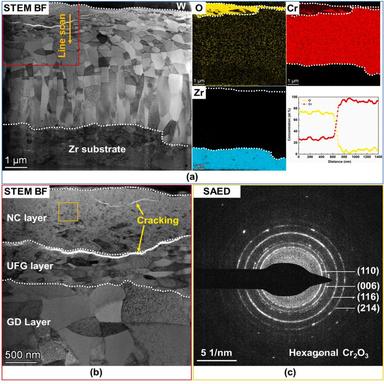
(a) Cross-sectional STEM image and the corresponding EDX maps and line-scan of worn area on Cr-coated cladding under 20 Hz; (b) magnified area of the NC layer, UFG layer, and GD layer; (c) SAED pattern of the NC layer.